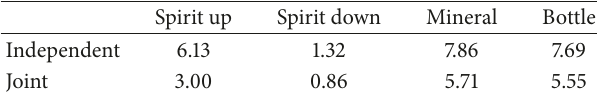
Table 2: Error of silhouettes